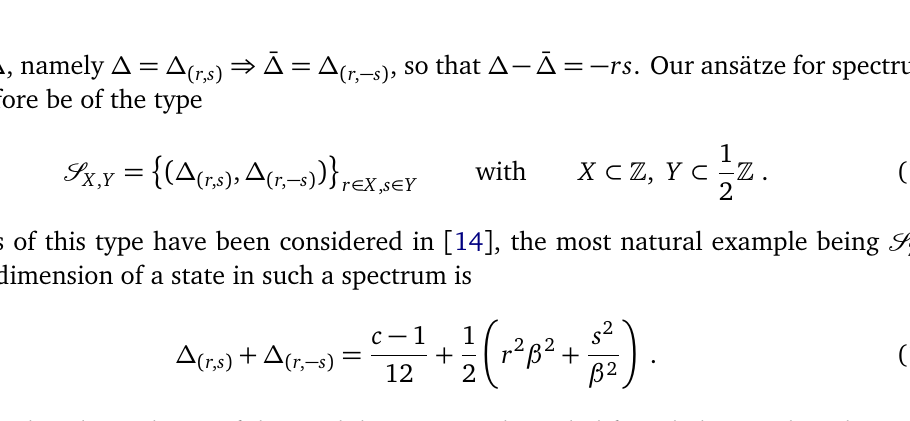
Table 3: Two ansätze for the spectrums of four-point